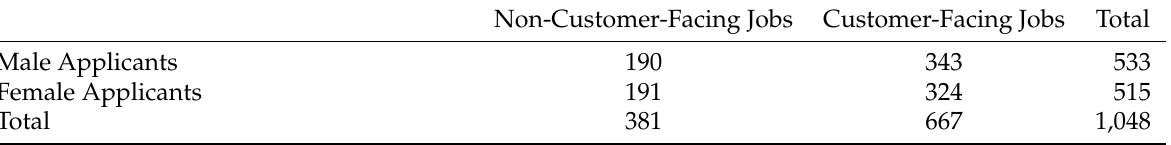
Table 1: Sampled job openings by job type and applicant